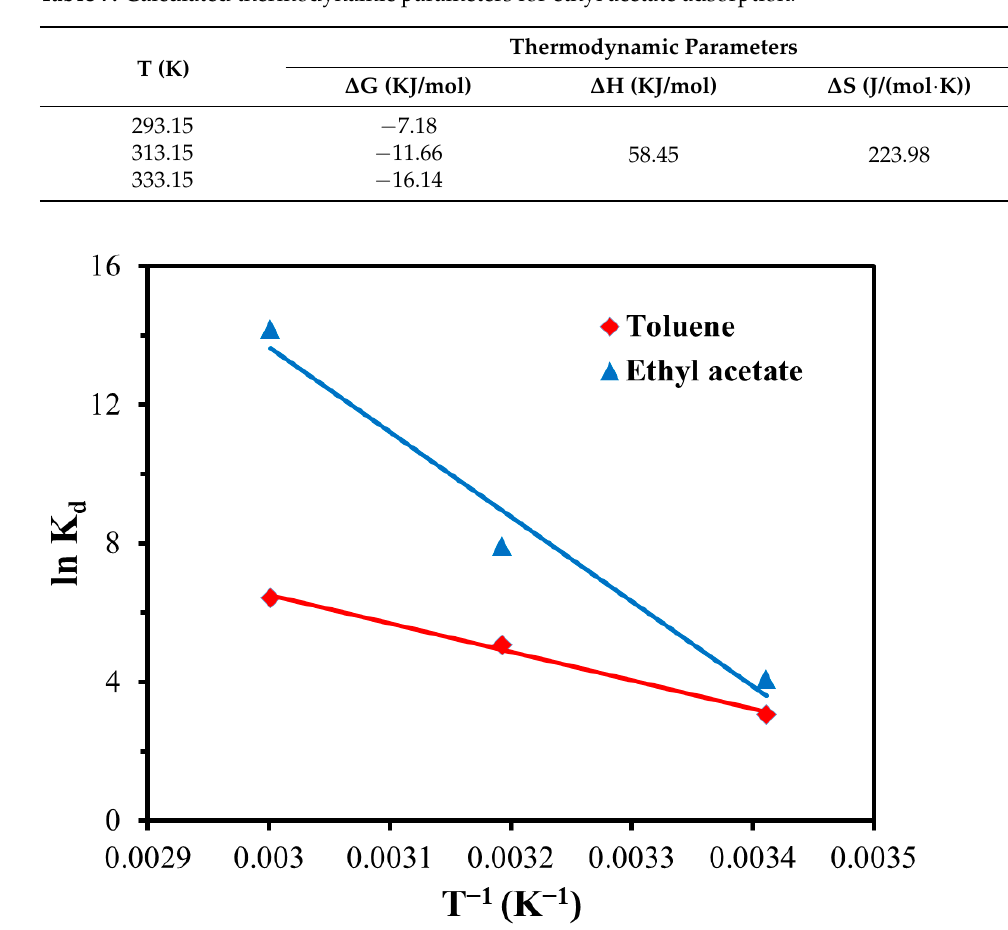
Figure 17. Thermodynamic fitting for the adsorption process of GQDs@ZIF-8 composites. Based on the above investigation of GQDs@ZIF-8 composites, the possible adsorp- tion mechanism of the composite is illustrated in Figure 18. The adsorption mecha- nism of the GQD/ZIF-8 composite for toluene and ethyl acetate mainly includes meso- mechanisms [43,63]. The channel-filling mechanism fundamentally affects the adsorp-